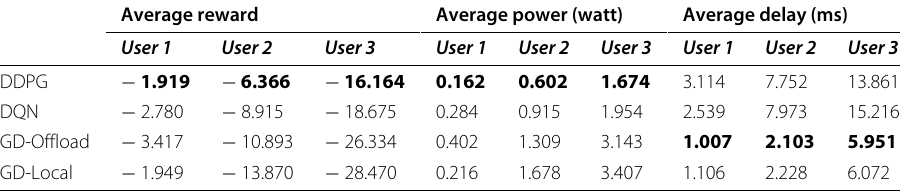
Table 3 Comparison of testing results with w m = 0.8 for all mobile users Average reward Average power (watt) Average delay (ms) User1 User2